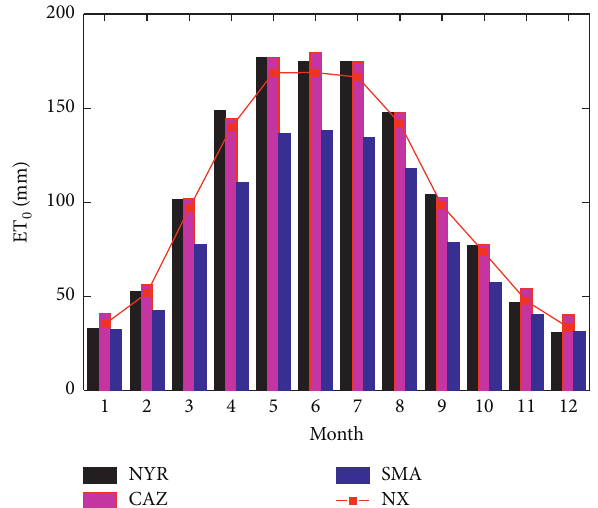
Figure 6: Monthly average of ET